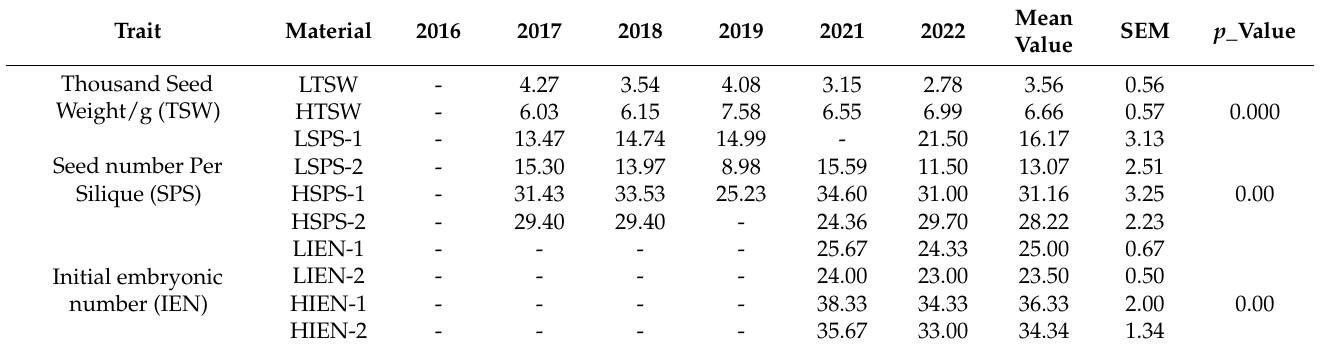
Table 4. Phenotypic analysis of yield-related extremely materials during multiple years of field